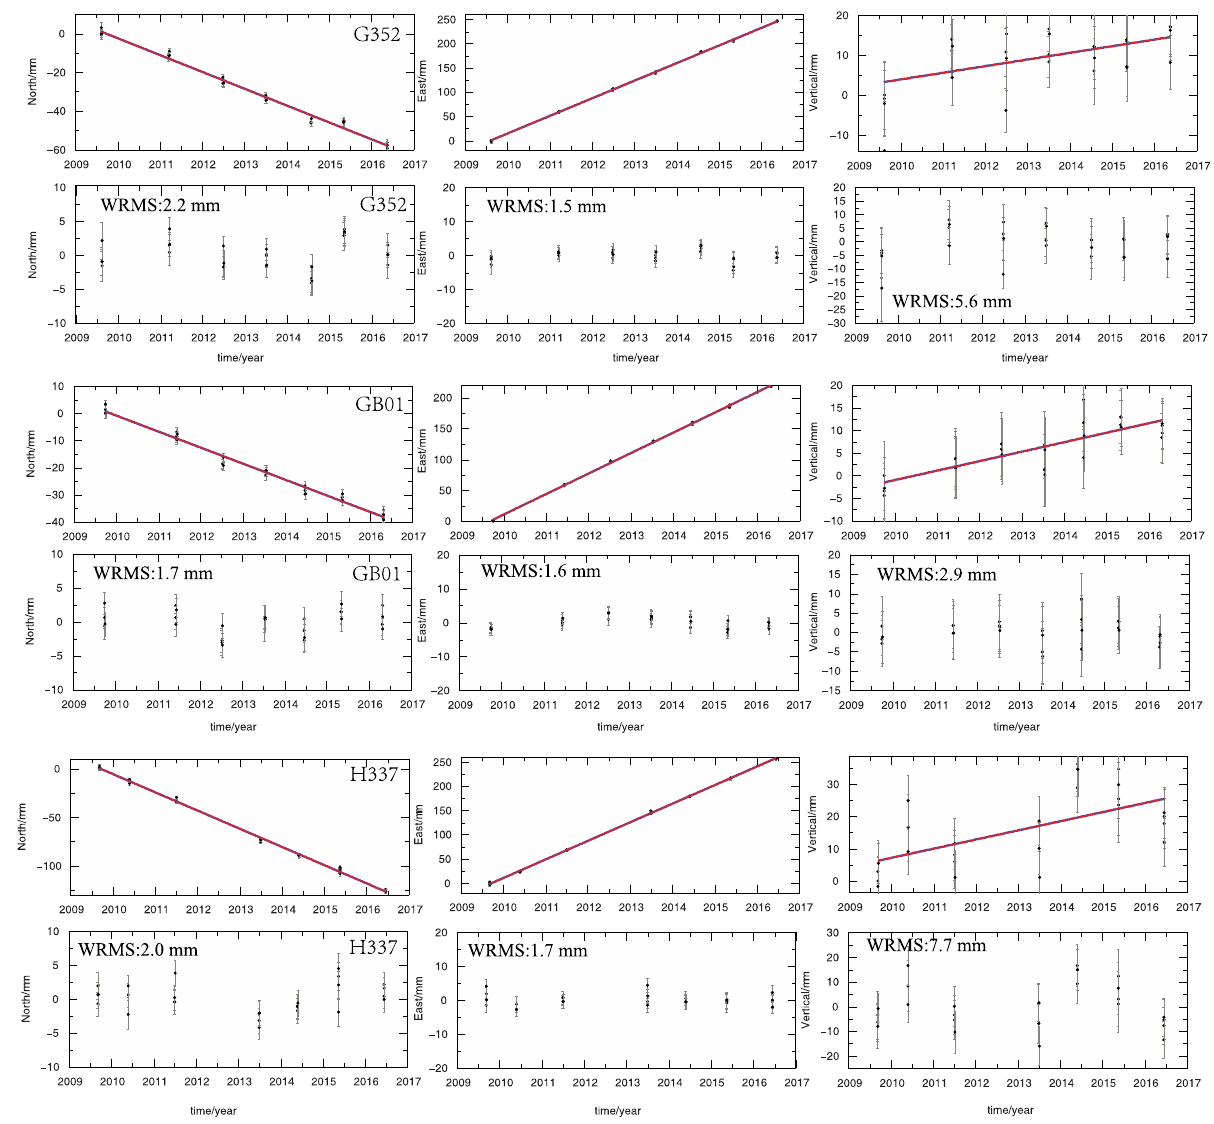
Figure 3. Time series and errors of the north ( left ), east ( middle ) and vertical ( right ) components of three GNSS campaign sites. The first two rows are for station G352, the third and fourth rows are for station GB01, and the fifth and sixth rows are for station H337. The red lines indicate the estimated velocities. The WRMS of every component are shown at the left up corner of error panels.